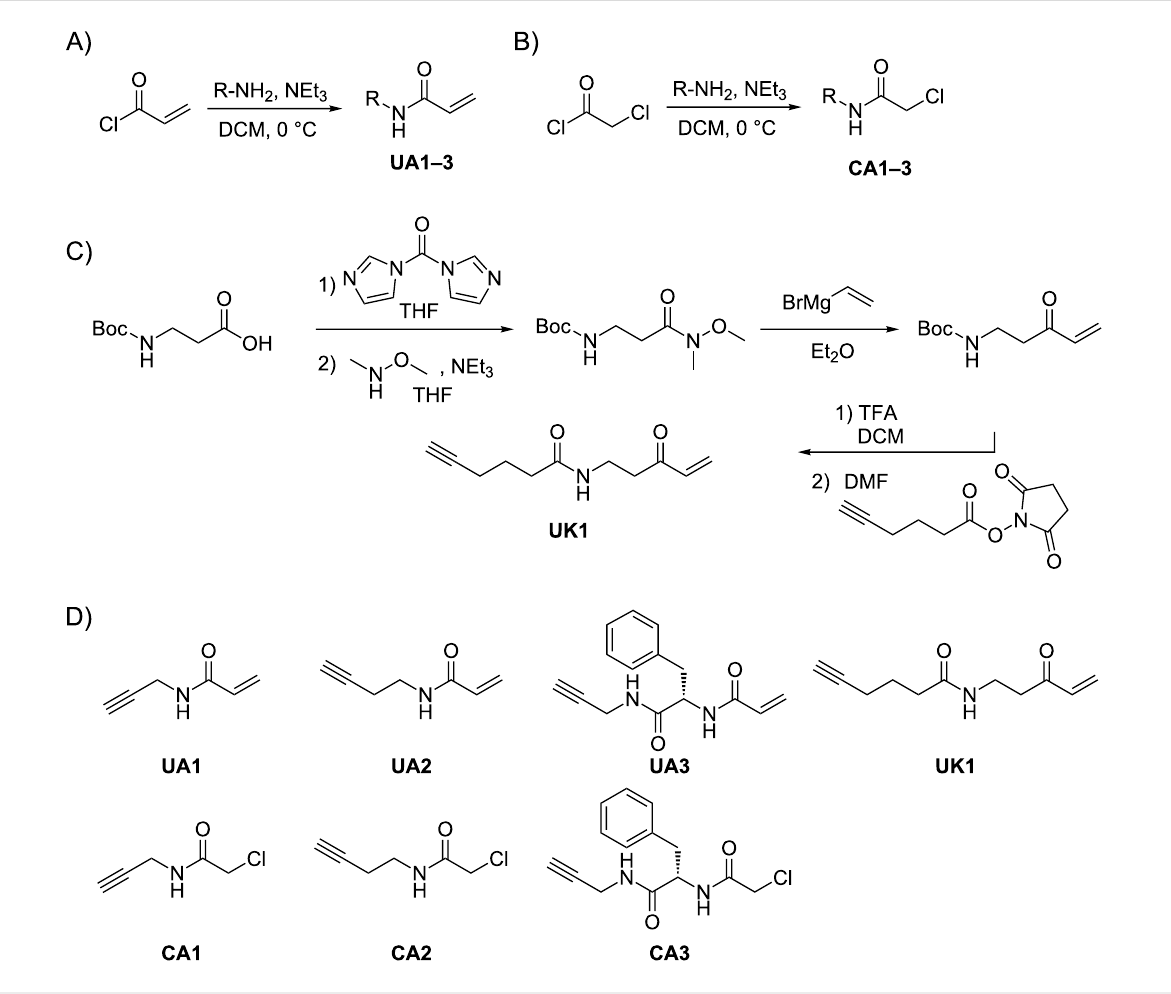
Figure 2: Synthesis of electrophilic ABPP probes. A) Synthesis of α , β -unsaturated amide probes UA1–3 . B) Synthesis of α -chloroacetamide probes CA1–3 , and C) synthesis of α , β -unsaturated ketone UK1 . D) Structures of the ABPP probe library.